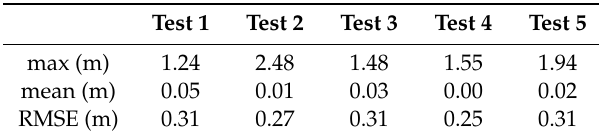
Table 5. Vertical positioning error.